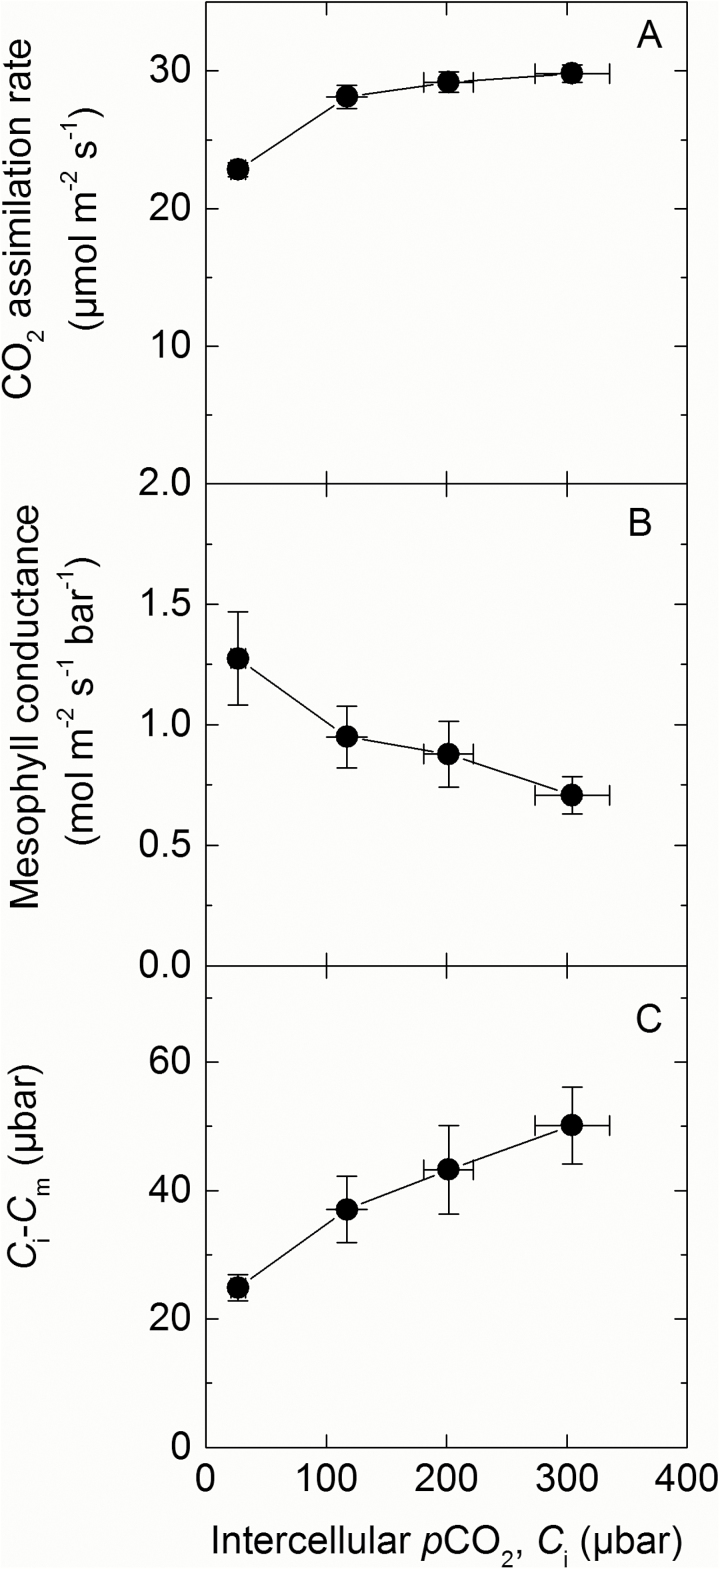
(A) CO2 assimilation rate, (B) mesophyll conductance (gm; Equation 2), and (C) Ci–Cm over a range of intercellular pCO2 in null controls measured using a LI-6400XT coupled to a tunable diode laser. Plants were grown at 2% CO2 and the uppermost, fully expanded leaves of 5-week-old plants were measured at 25 °C leaf temperature, flow rate 200 µmol m−2 s−1, 2% O2 at an irradiance of 1500 µmol photons m−2 s−1.